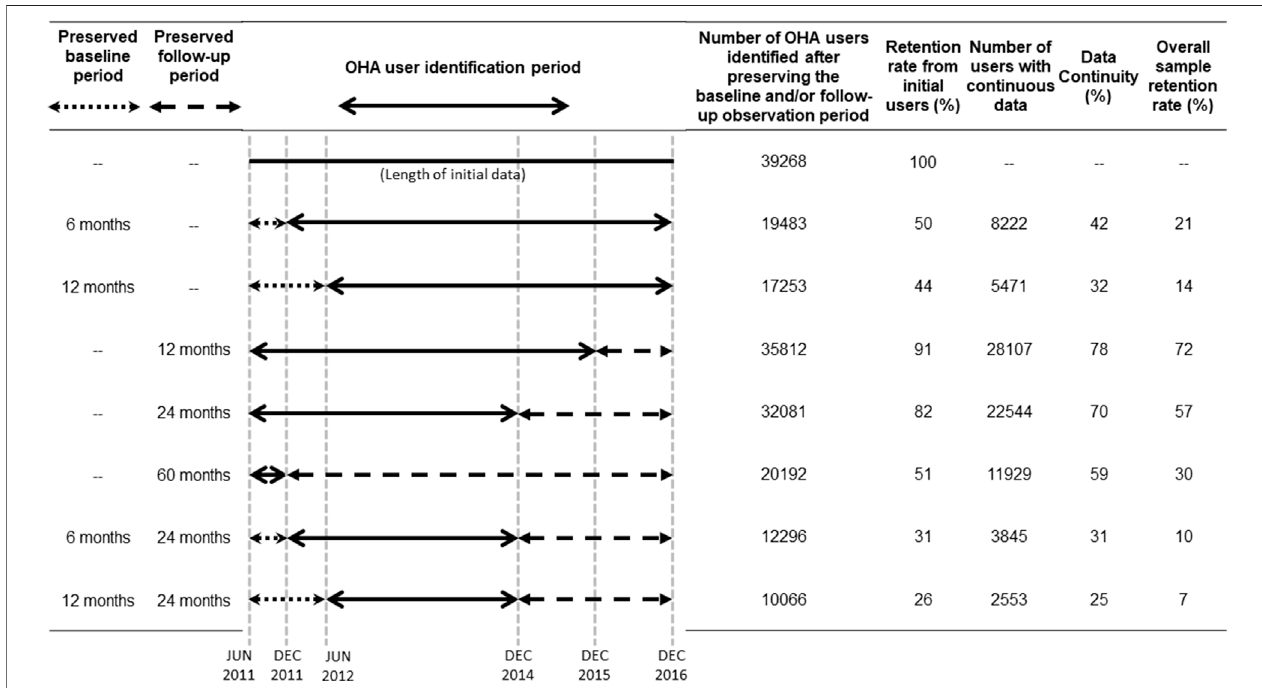
FIGURE 1 | Cohort identi fi cation periods and numbers of eligible oral hypoglycemic agent users in the Integrated Medical Database of National Taiwan University Hospital. Solid lines represent the oral hypoglycemic agent (OHA) user identi fi cation periods; dotted lines represent the baseline periods of interest, and dashed lines represent the follow-up periods of interest. Baseline and follow-up periods were de fi ned based on the fi rst OHA prescription (i.e., the index date) observed in the OHA user identi fi cationperiod.Datacontinuitywasassessed duringthebaseline andfollow-upperiodsofinterest.Wede fi nedpatientsashavingcontinuousdataifthey had at least one encounter or prescription in the electronic health record database within a given 90-day